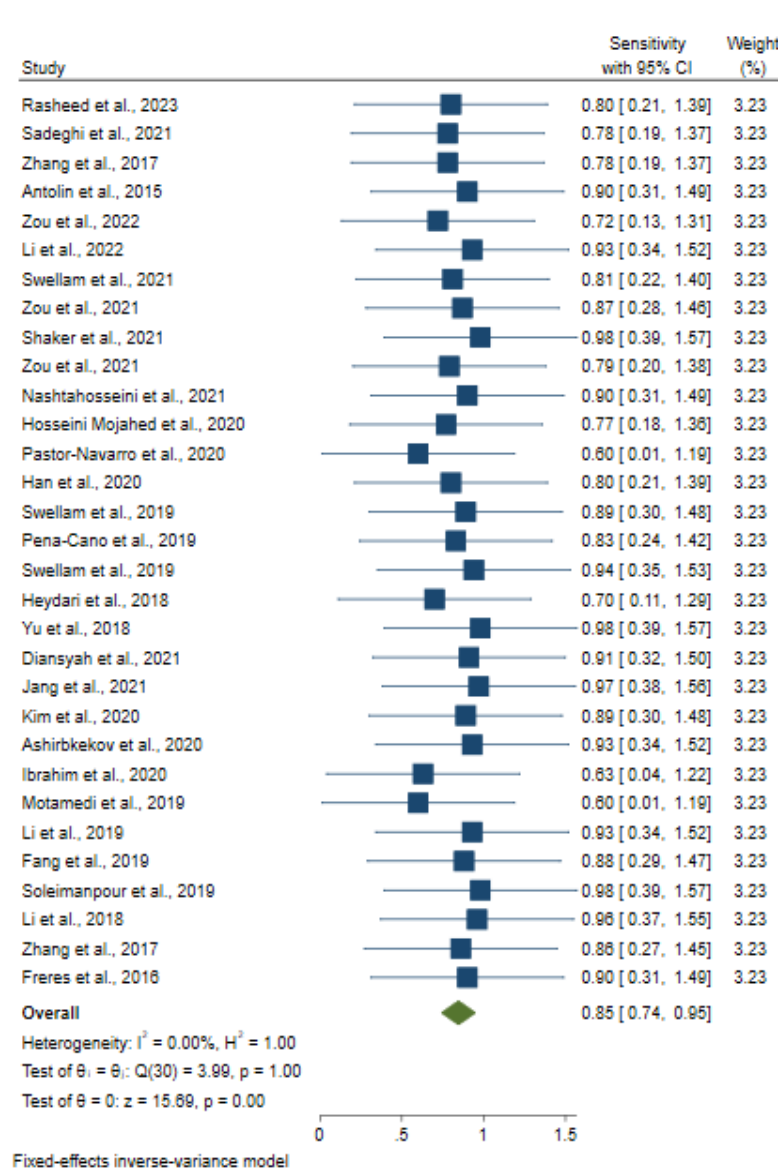
Fig. 9. Sensitivity of circulating microRNAs to diagnose breast